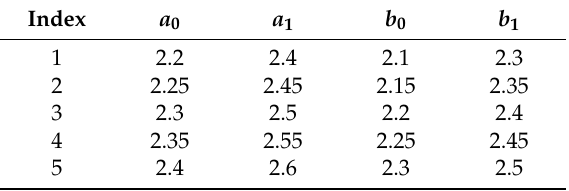
Table 10. Different Values of a 0 , a 1 , b 0 , and b 1 for sensitivity analysis of (1,